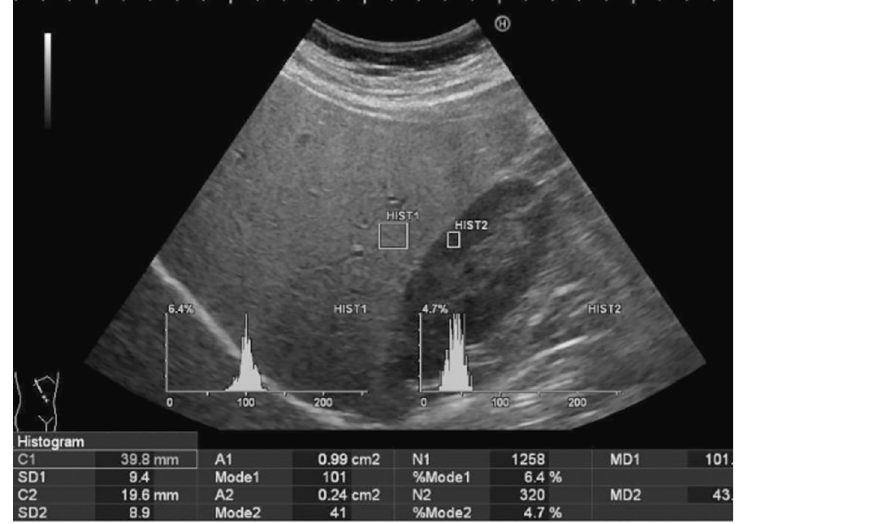
Fig 1. HRI measurement on a volunteer with mild hepatic steatosis (HRI = 2.33).